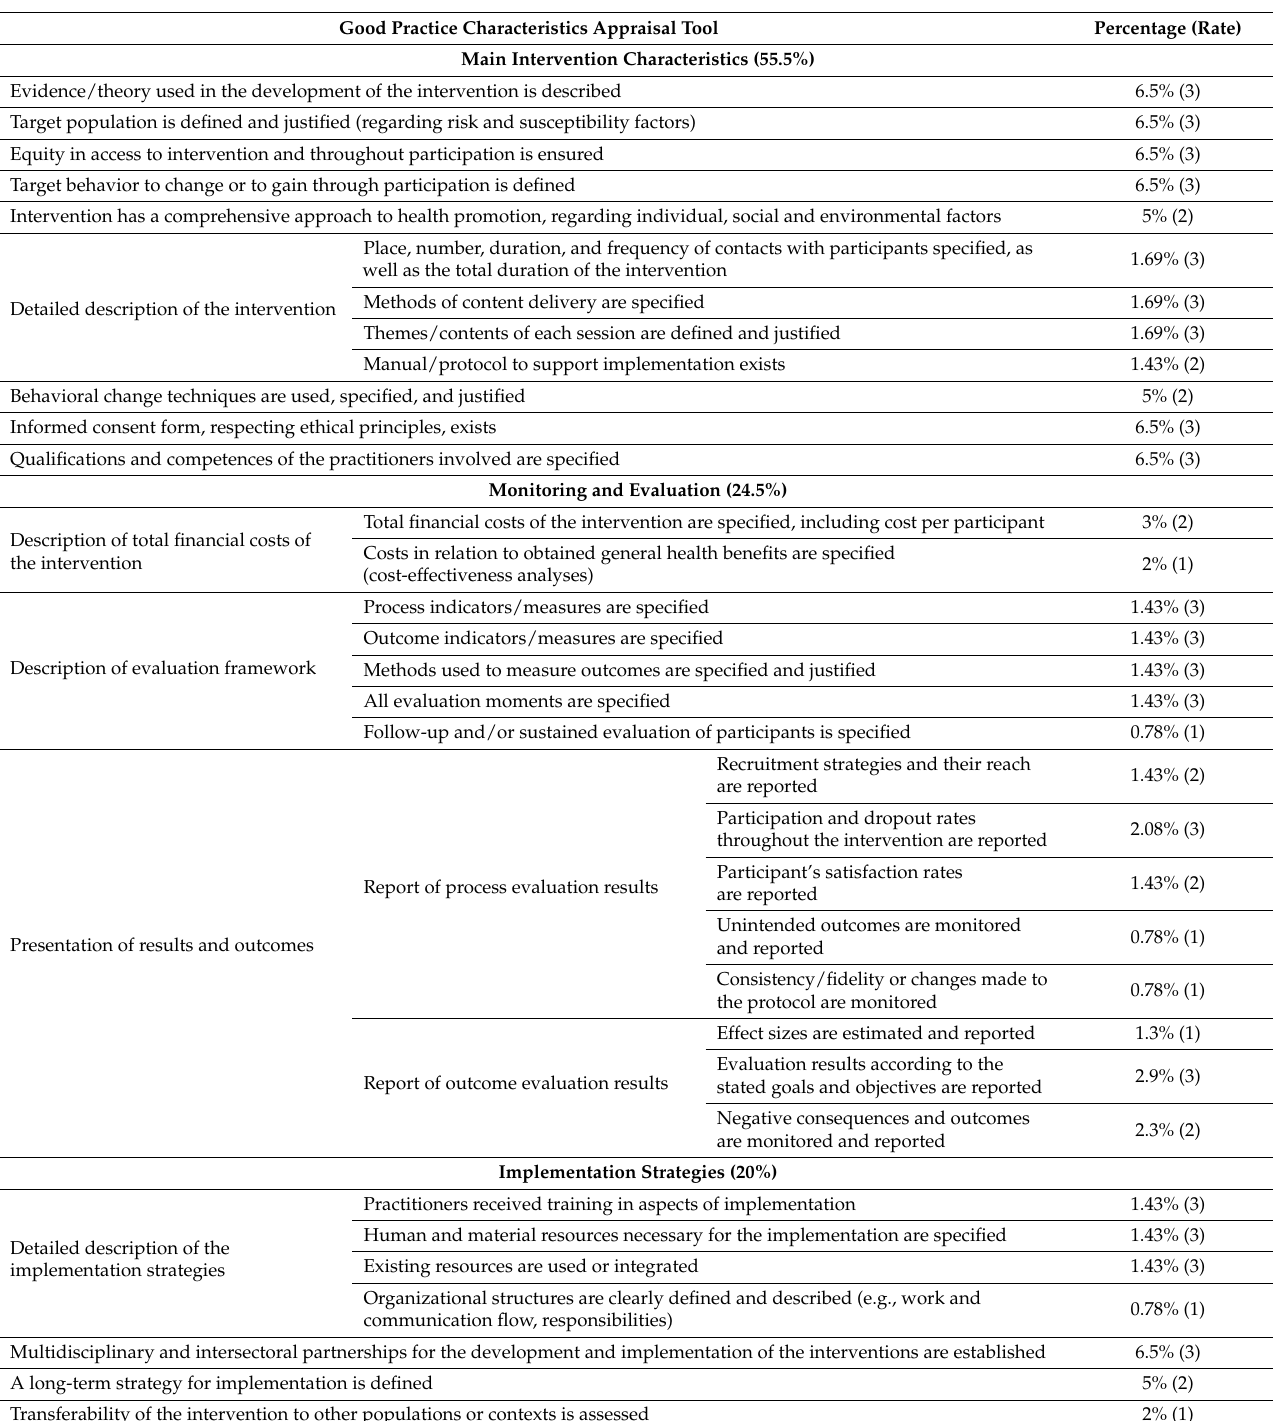
Table 1. Good Practice Characteristics Appraisal